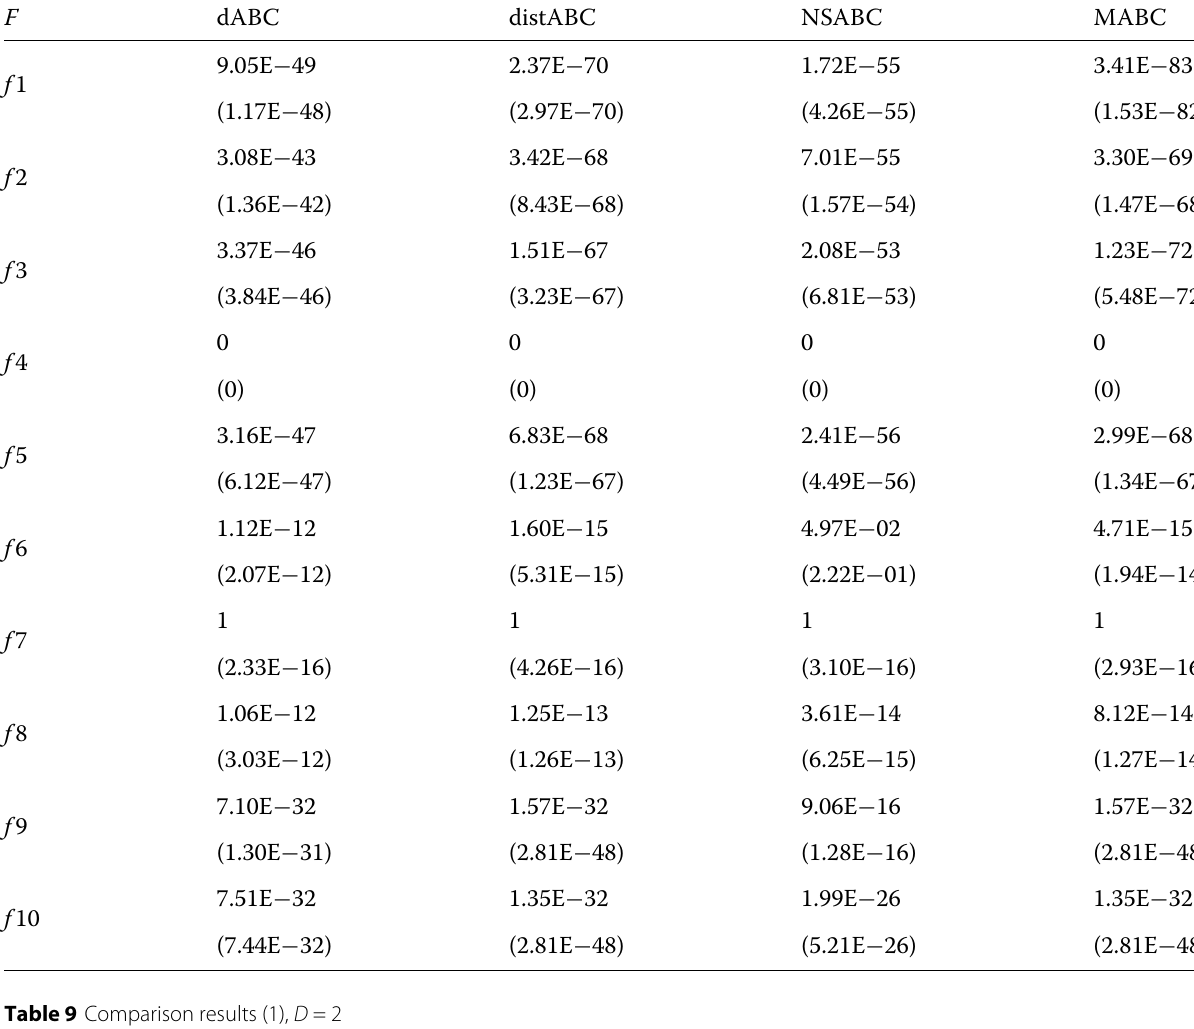
Table 8 Comparison results (2), D = 50